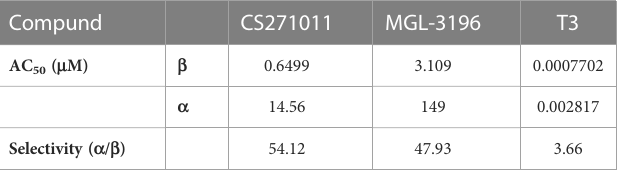
TABLE 1 Activation of THR- b and THR- a for CS271011, MGL-3196 and T3. Compund